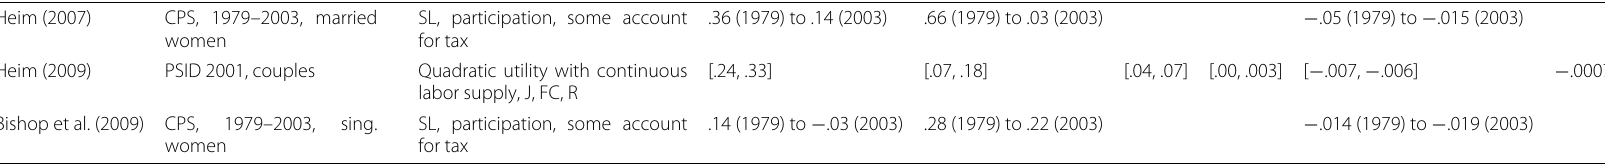
Table 3 Labor supply elasticities for the USA (Continued) Heim (2007) CPS, 1979–2003, married SL, participation, some account .36 (1979) to .14 (2003) .66 (1979) to .03 (2003) − .05 (1979) to − .015 (2003) women for tax Heim (2009) PSID 2001, couples Quadratic utility with continuous [.24, .33] [.07, .18] [.04, .07] [.00, .003] [ − .007, − .006] − .0007 labor supply, J, FC, R Bishop et al. (2009) CPS, 1979–2003, sing. SL, participation, some account women for